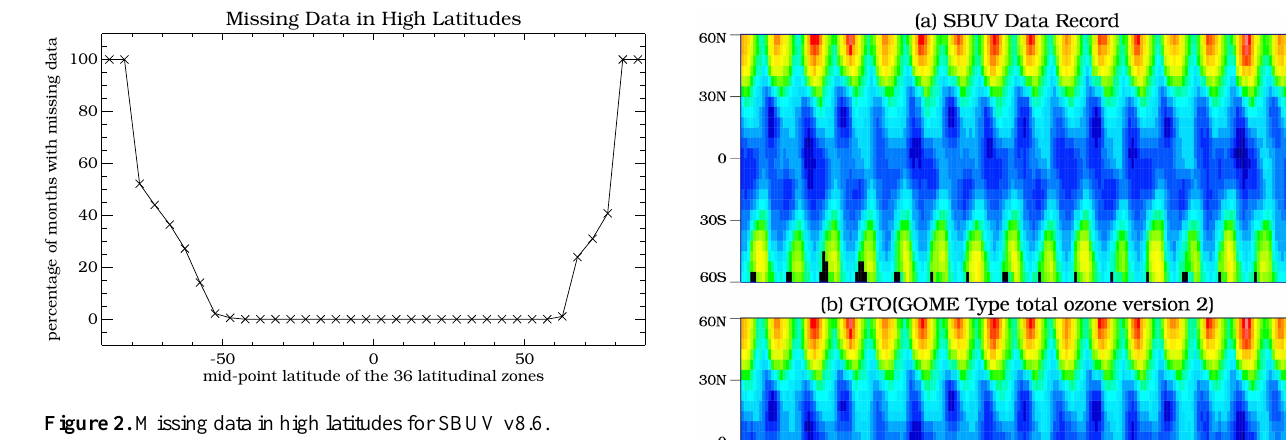
Figure 3. Monthly mean zonal mean total column ozone (5- degree zones): (a) SBUV, (b) GTO (GOME-type total ozone), and (c) ground-based data record. (Black regions represent missing data in SBUV v8.6.)